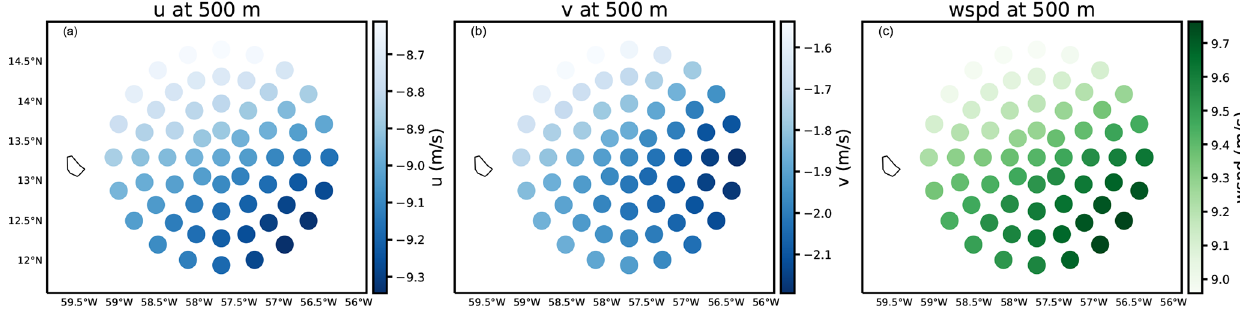
Figure 4. Spatial variability of wind components (zonal u , meridional v , and wind speed – wspd) at 500m derived from ERA5 for the whole period and at all